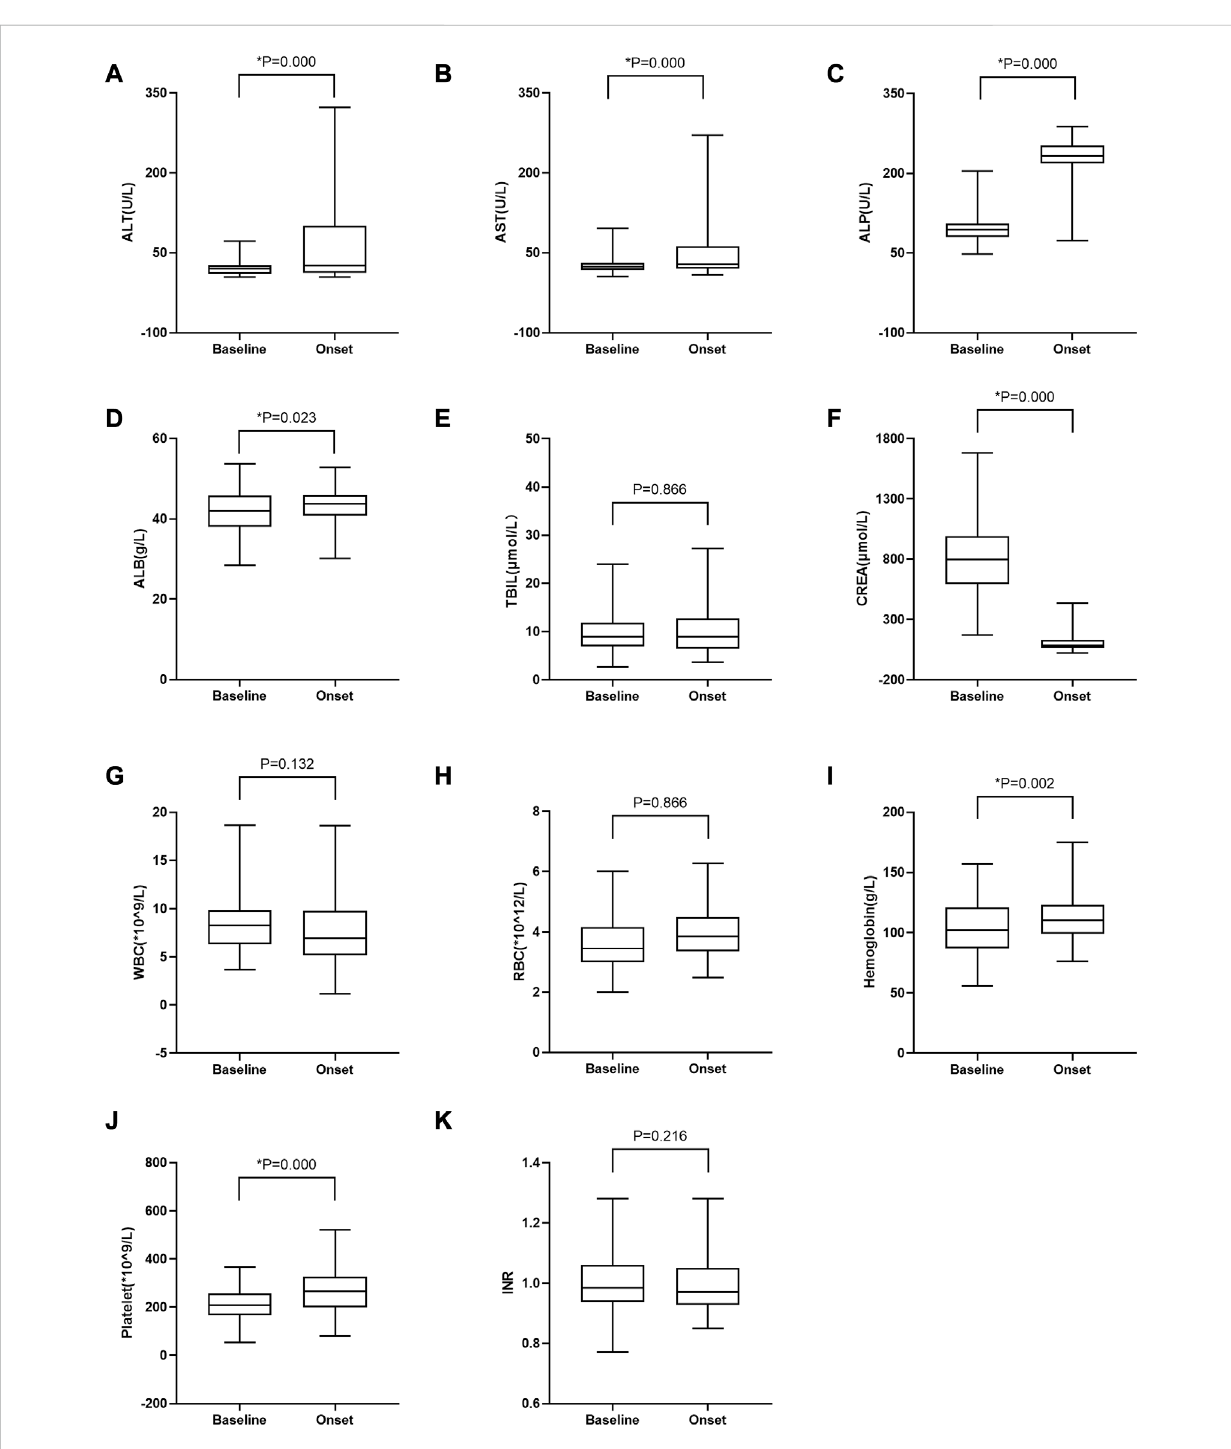
FIGURE 3 Changes in laboratory test values between baseline and at tac-DILI onset post-tacrolimus treatment in patients with tac-DILI ( n = 90). (A) ALT; (B) AST; (C) ALP; (D) ALB; (E) TBIL; (F) CREA; (G) WBC; (H) RBC; (I) Hemoglobin; (J) Platelet; (K) INR. Horizontal bars represent the median value, boxes represent the interquartile range and whiskers indicate the minimum and maximum value. Wilcoxon ’ s test was used to compare laboratory test values between baseline and at tac-DILI onset post-tacrolimus treatment. * p < 0.05. ALT: alanine aminotransferase; AST: aspartate aminotransferase; ALP: